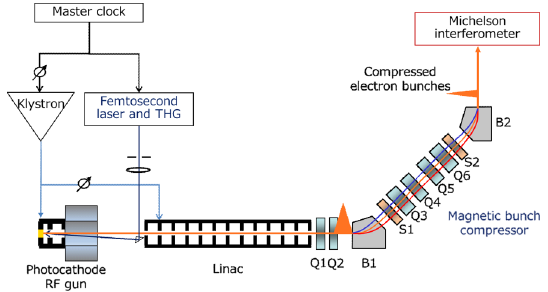
FIG. 1. Schematic diagram of a laser photocathode rf electron gun linac. Q1-6: quadrupole magnet; B1, 2: bending magnet; S1, 2: sextupole magnet. The rf electron gun was a 1.6-cell electron gun, and a solenoid magnet was equipped immediately after the gun exit. The linac tube was composed of 54 cells. The magnetic bunch compressor was composed of a pair of bending magnets, two pairs of quadrupole magnets, and a pair of sextu- pole